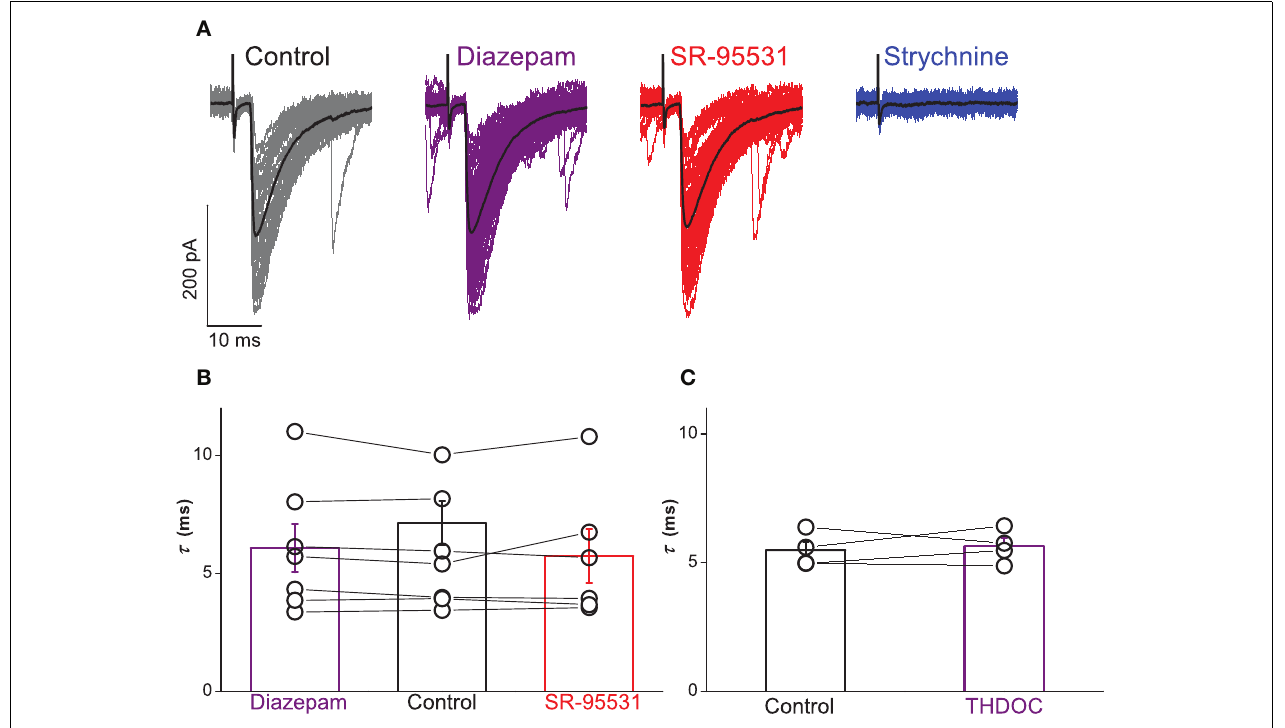
(blue) abolished all responses. Group data for all motoneurons are represented in graph (B) , which illustrates no significant effect of diazepam (purple) or SR-95531 (red) on the time constant. Graph (C) shows no significant effect of 200nMTHDOC (purple) on the time constant of responses evoked in transverse slices (see